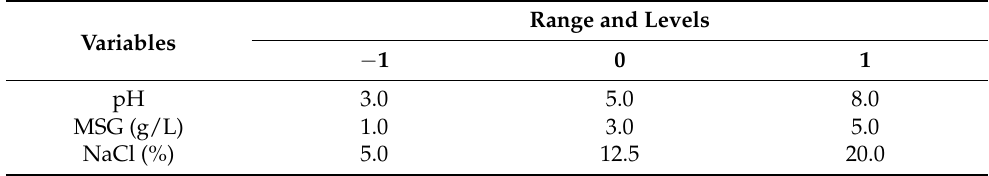
Table 1. The selected factors and levels used for RSM optimization of GABA.